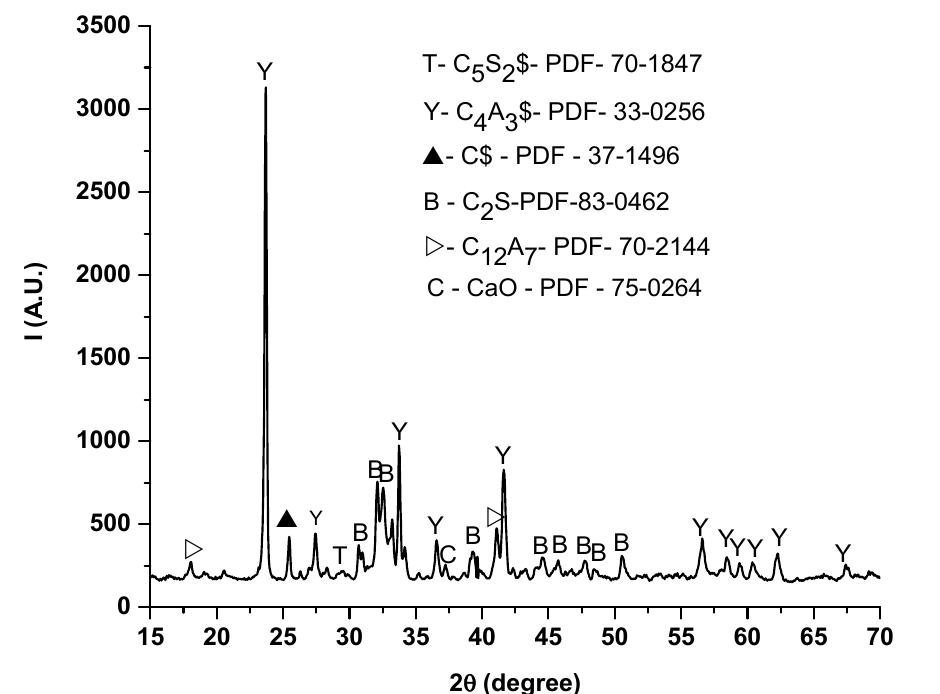
Figure 2. X-ray diffraction pattern on obtained clinker at 1300 °C. (C-CaO, S-SiO 2 , A-Al 2 O 3 , $-SO 3 ).